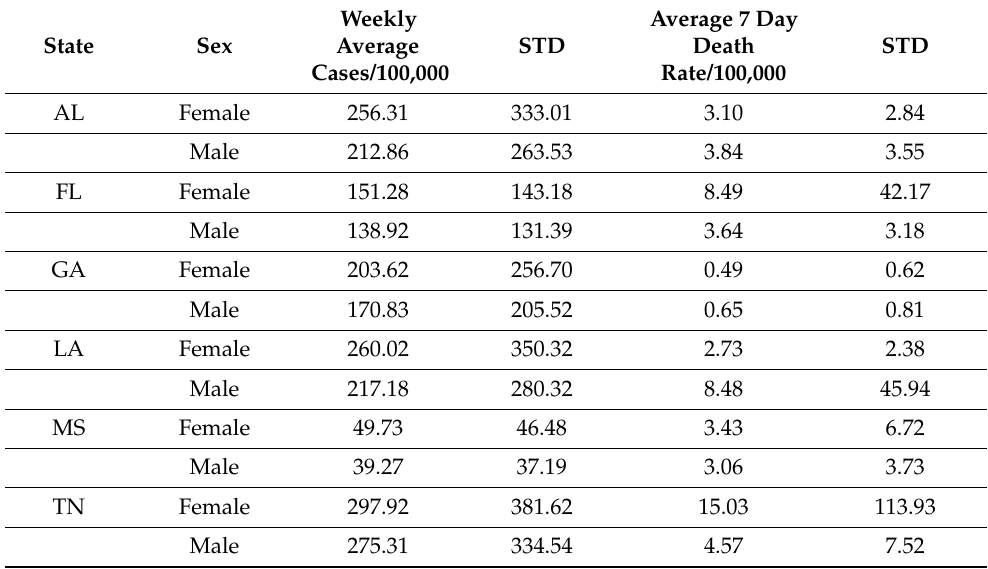
Table 1. Rates of COVID-19 cases and death rates by sex in the selected states.